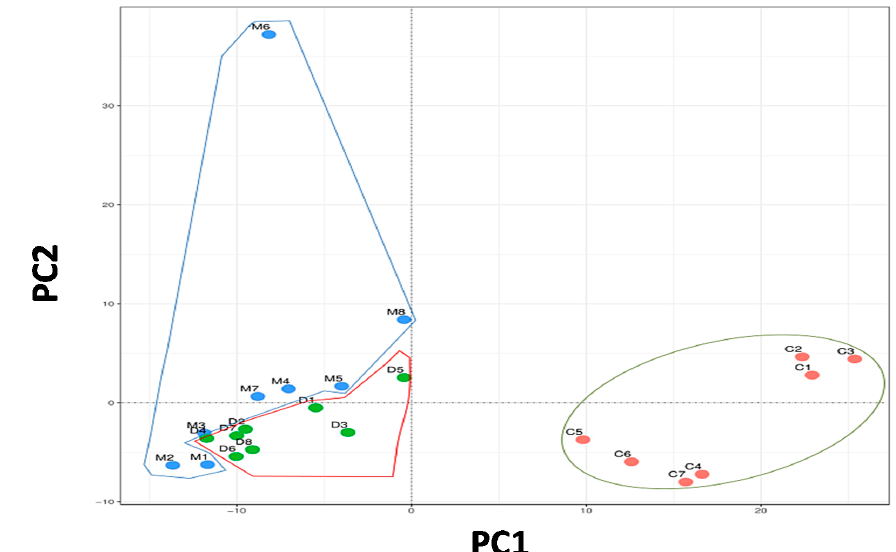
Figure 2. Principal component analysis (PCA) of gut microbiota metagenomes. The PCA analysis distribution of the faecal community respect to diet and treatment and the microbiota composition. ( C ) Control; ( D ) DIO; ( M ) DIO + MaR1. Groups were enclosed representing the similarity among the